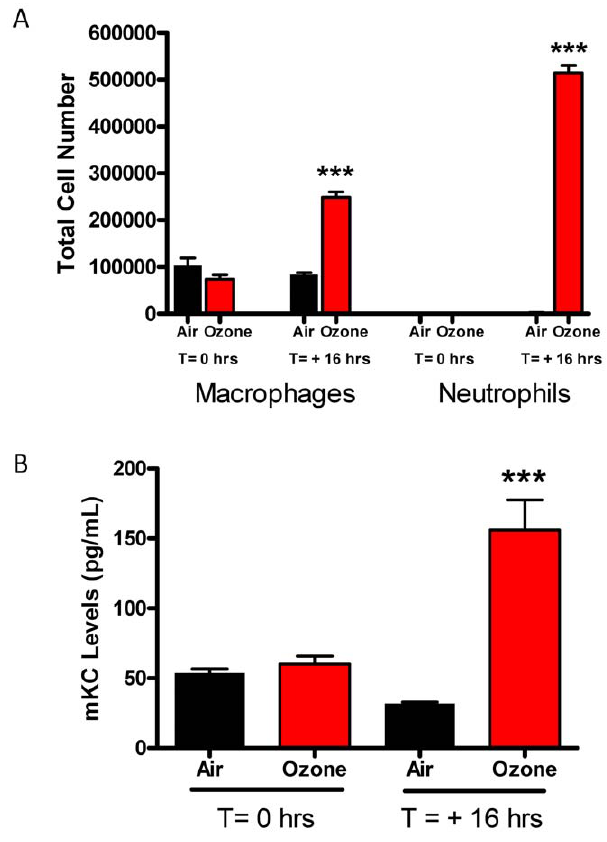
Figure 2. BAL fluid cell counts and KC levels following ozone exposure. Broncho-alveolar lavage (BAL) fluid was collected from mice following exposure to ozone (6 ppm; 2 h) either immediately following exposure (T=0 h) or the following day (T= + 16 h). (A) Macrophage and neutrophil cell counts; (B) mouse (m)KC levels. Data expressed as mean 6 SEM shown; *** P # 0.001 vs. filtered air control.